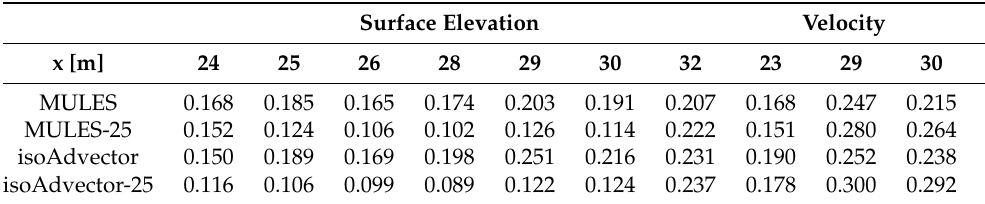
Table 1. nRMSE figures for modelled surface elevations and velocities at different probe locations, both for the full 50 s time series and a shorter 25 s time